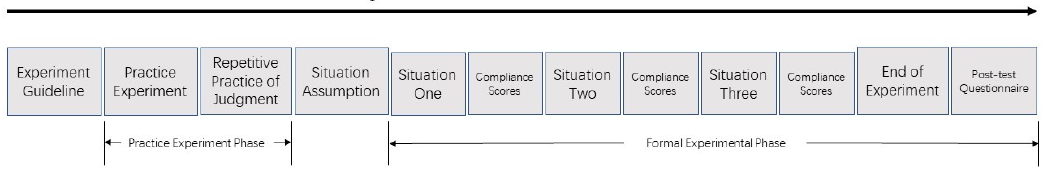
Figure 4. Experimental Procedure for Attribute Framework Effects.